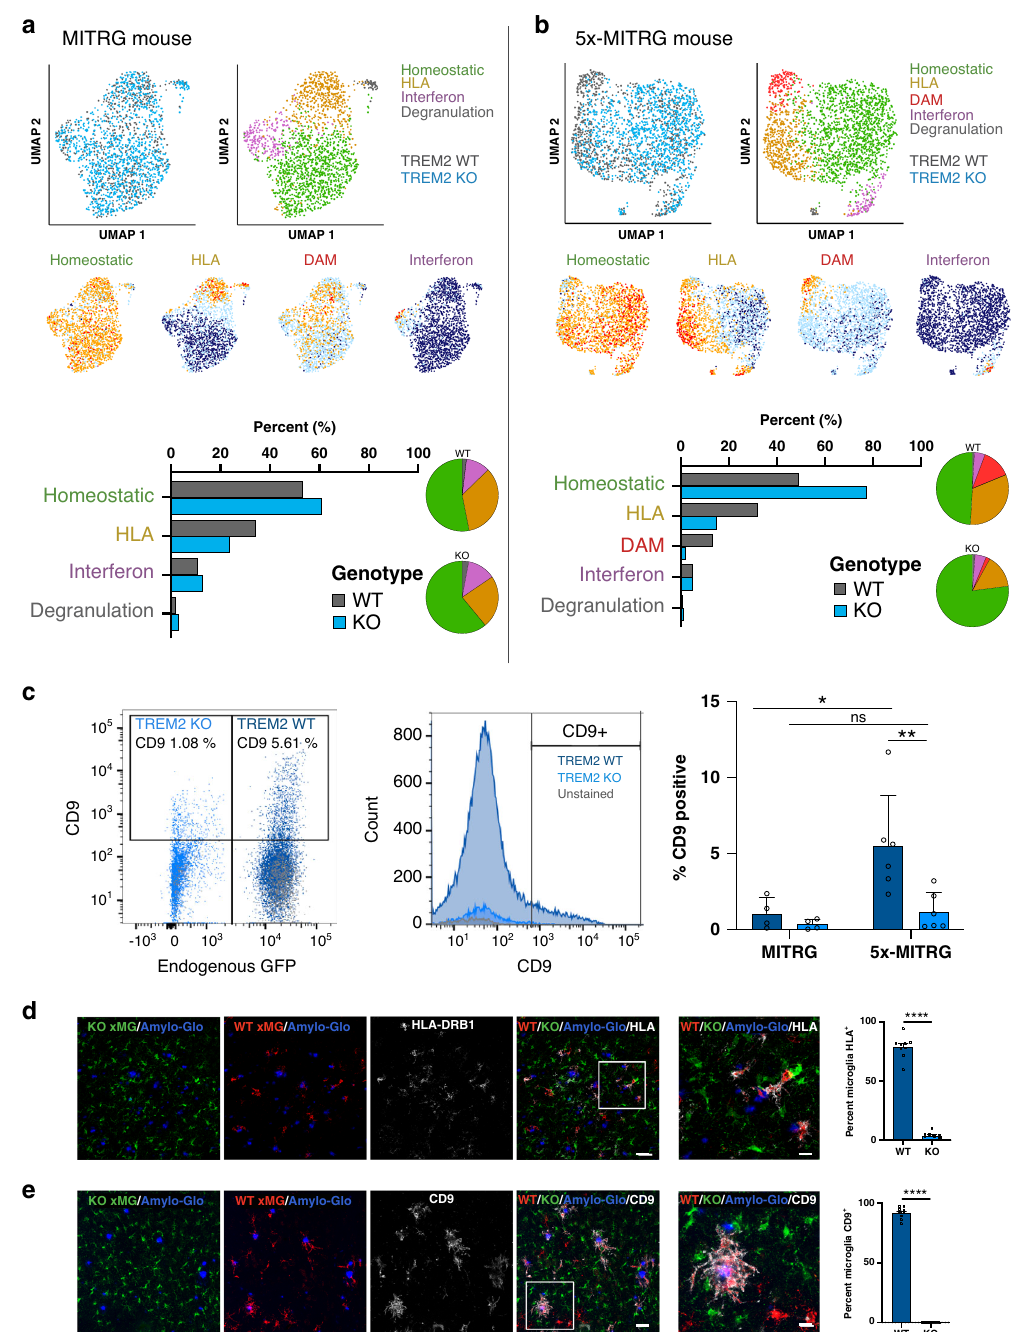
phenotypes (Fig. 6a, b bar and pie graphs, Supplementary Table 1, WT and 5x analyzed together in Supplementary Data